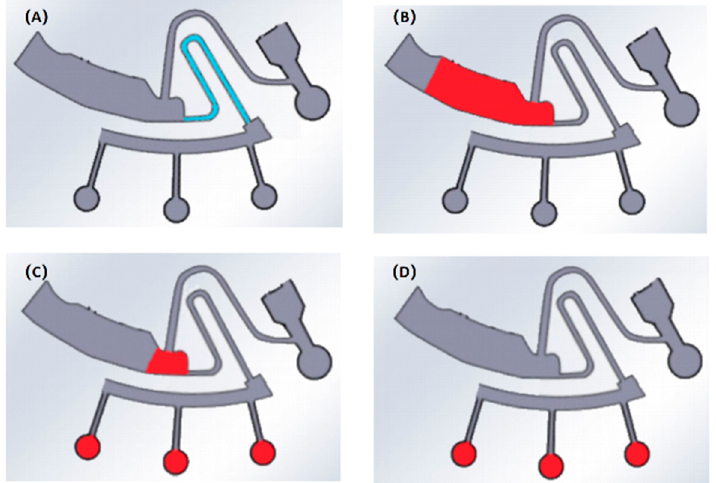
Figure 4. Schematic diagram of on-chip liquid transfer: ( A ) add hydrophilic reagent; ( B ) inject red ink; ( C ) centrifugal process; ( D ) extract and calculate. ink; ( C ) centrifugal process; ( D ) extract and